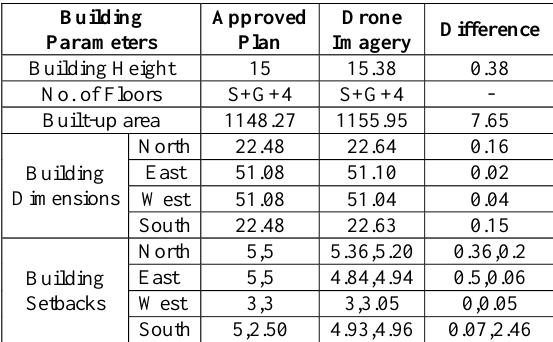
Table 2: Building 2 measurements derived from